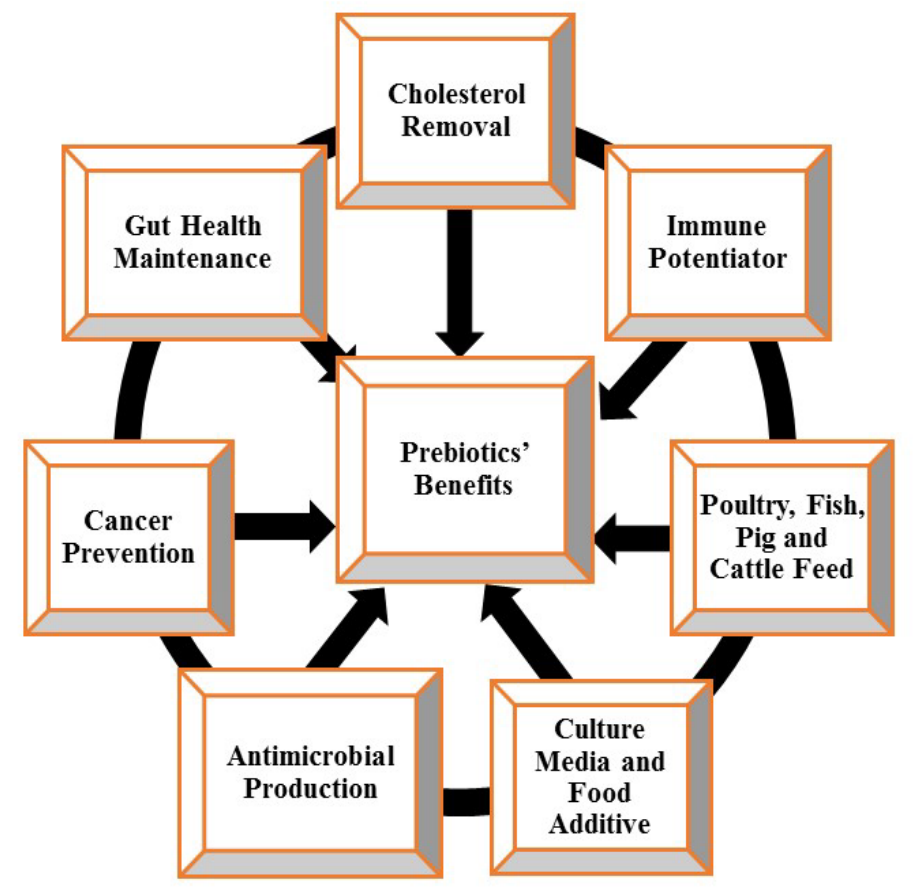
Figure 3. Potential applications of prebiotics.